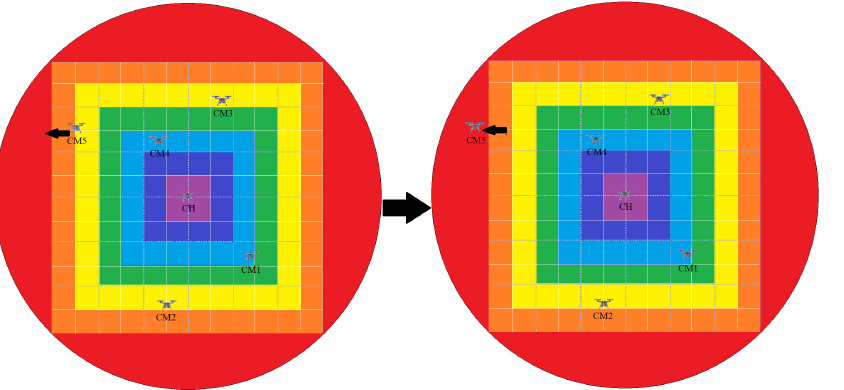
Figure 4. CM 5 moves from yellow grid to red